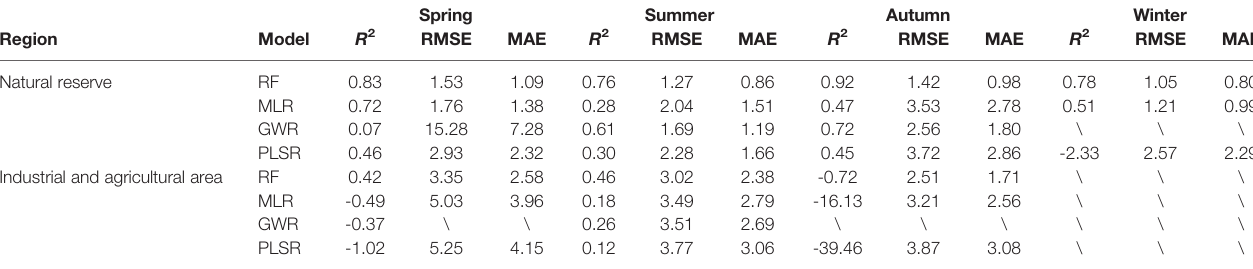
TABLE 1 | Statistics for the comparison of seasonal model cross-validation